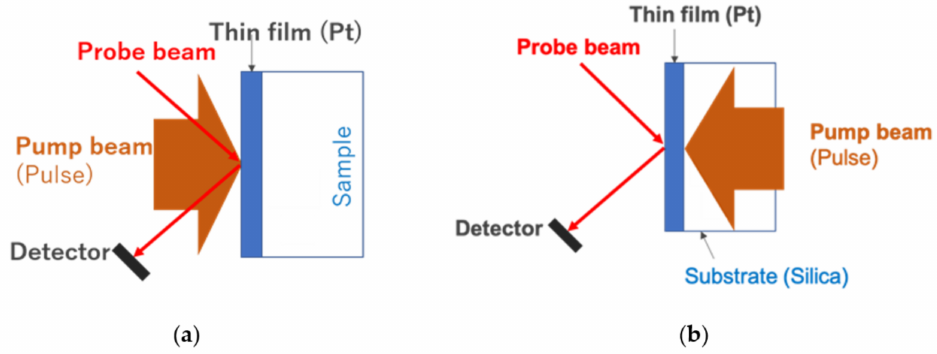
Figure A1. Diagram of thermo-reflectance measurement with ( a ) front-detect (FF) configuration and ( b ) rear-heat front-detect (RF) configuration. After depositing the Pt layer on the surface, samples consisted of three layers (see Figure A2).